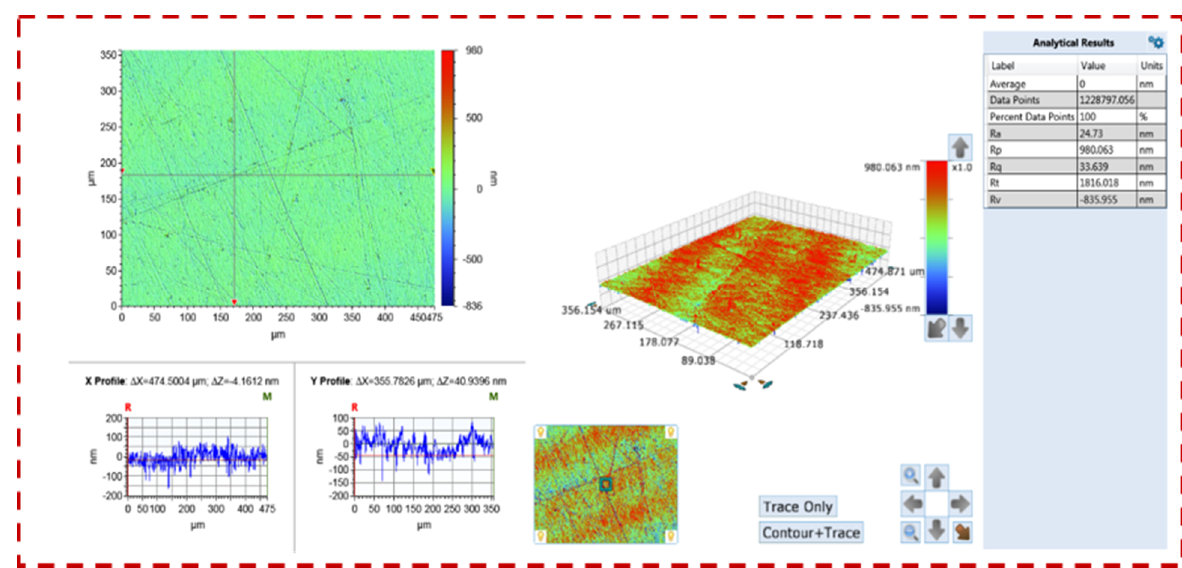
Figure 21. 2D and 3D morphologies and surface roughness of the Si-plane surface after being polished by the consolidated abrasive particles.